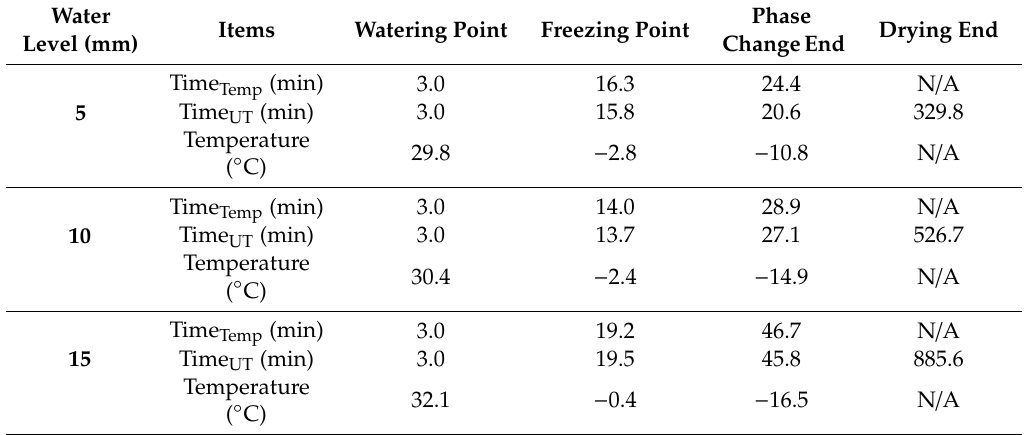
Figure 9. Amplitude variations of ultrasonic L 3 echo with respect to various water levels at drying stage. Water level: ( a ) 5, ( b ) 10 and ( c ) 15 mm. Table 2. Timings and temperatures of water in, freezing point, phase change end and drying end indicated by temperature and ultrasonic L 3 echo for water levels of 5, 10, 15